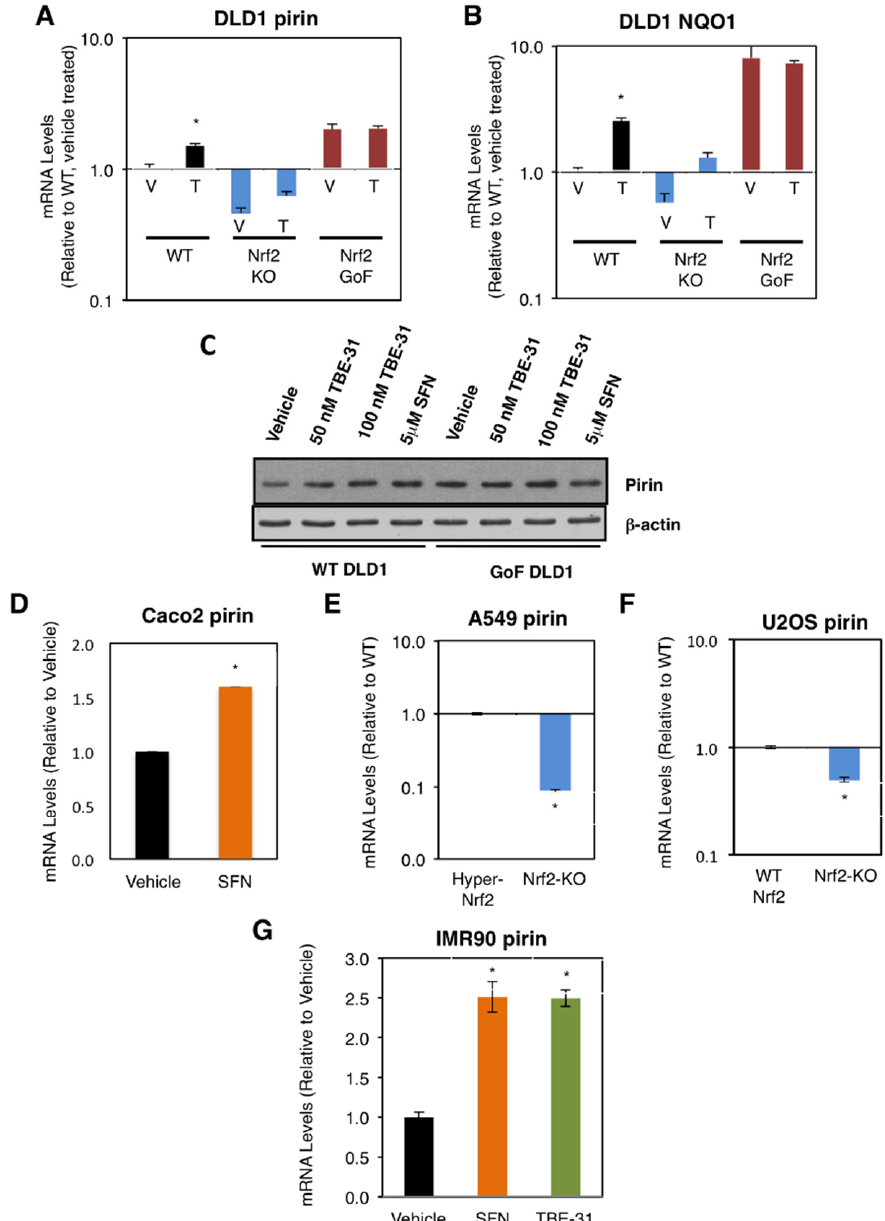
Figure 1. Pirin is a transcriptional target of Nrf2 in human cells. ( A , B ) mRNA levels for pirin ( A ) and NQO1 ( B ) in Nrf2-wild-type (WT), Nrf2-knockout (Nrf2-KO), and Nrf2 gain-of-function mutant (Nrf2-GoF) human DLD1 colorectal cancer cells treated with vehicle (V) or 10 nM TBE-31 (T) for 16 h. ( C ) Protein levels for pirin in Nrf2-wild-type (WT) and Nrf2 gain-of-function mutant (Nrf2-GoF) human DLD1 colorectal cancer cells treated with vehicle, 50 nM TBE-31, 100 nM TBE-31, or 5 µ M sulforaphane (SFN) for 16 h. ( D ) mRNA levels for pirin in Caco2 colorectal cancer cells treated with vehicle or 5 µ M SFN for 24 h. ( E ) mRNA levels for pirin in A549 cells (high Nrf2 levels, “Hyper-Nrf2”) and their Nrf2-knockout (Nrf2-KO) mutant counterparts. ( F ) mRNA levels for pirin in U2OS cells (normal Nrf2 levels, WT Nrf2) and their Nrf2-knockout (Nrf2-KO) mutant counterparts. ( G ) mRNA levels for pirin in IMR90 normal human lung fibroblasts treated with vehicle, 5 µ M SFN or 100 nM TBE-31 for 16 h. * p < 0.05. The TaqMan data were normalized using human hypoxanthine phosphoribosyltransferase 1 (Hprt1) as an internal control.